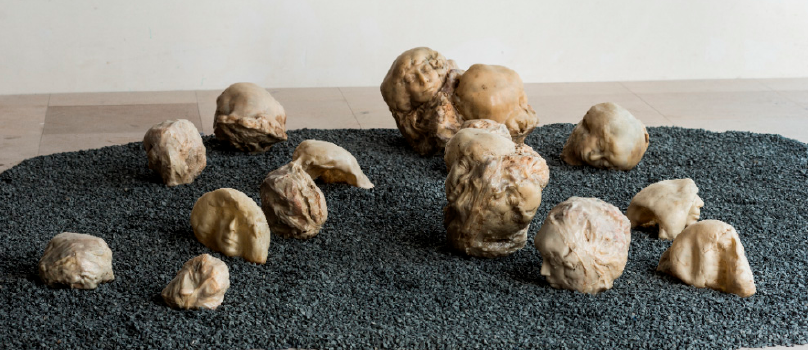
Figure 5. Alina Szapocznikow, Tumors Personified , 1971 , polyester resin, fiberglass, paper, gauze, various dimensions, Zach ę ta National Gallery of Art, Warsaw. © ADAGP, Paris. Courtesy of The Estate of Alina Szapocznikow/Piotr Stanislawski/Galerie Loevenbruck, Paris/Hauser & Wirth. In Alina’s Funeral (Figure 6), Szapocznikow predicted her own death and described herself as an accumulation of materials stuck together to create a kind of corpse. She is not human, but a sticky, bubbling mass from which we see more anthropomorphized tumors emerging. This image is reminiscent of the photographs that documented the mass graves of humans with their organs tangled together that were discovered during the liberation of the concentration and extermination camps.